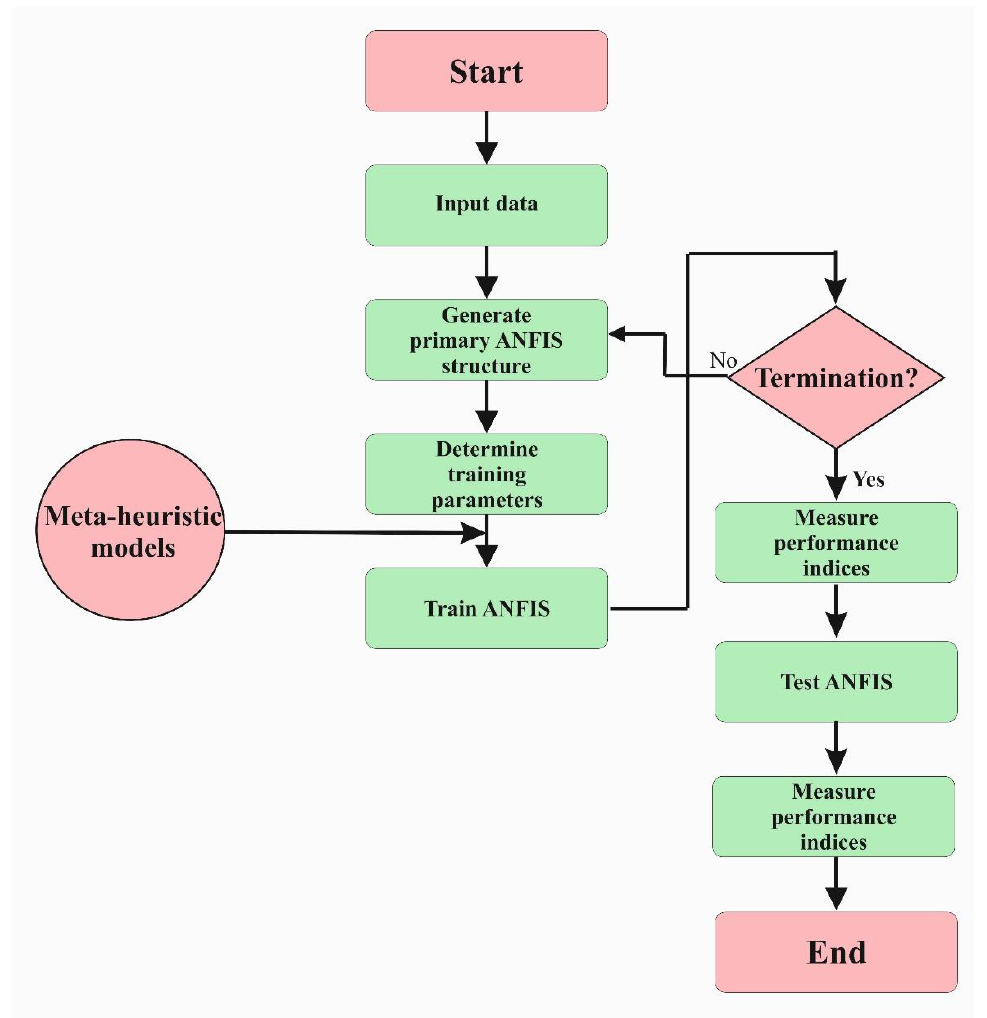
Figure 2. The hybridization procedure for providing an optimistic adaptive neural fuzzy inference systems (ANFIS) model.